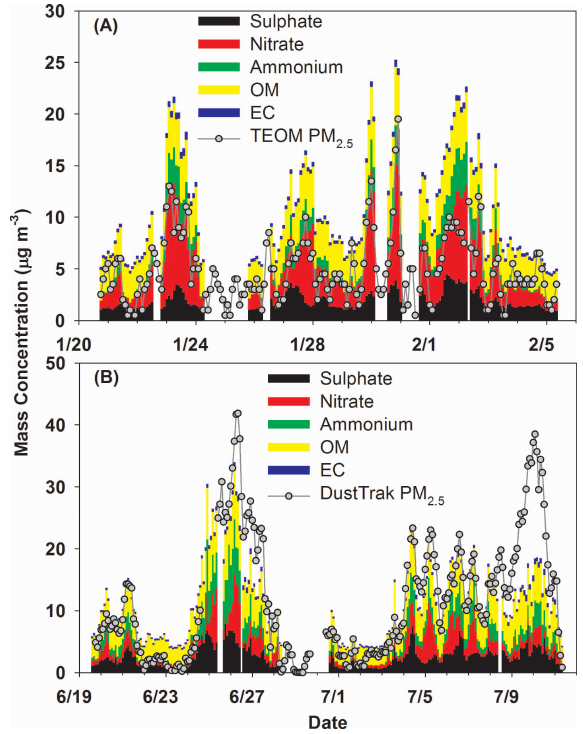
Fig. 6. Stacked two hour resolution chemical species calculated by using scaled ATOFMS RPA and measured PM 2 . 5 mass concentra- tions by the TEOM in Toronto (A) and the DustTrak in Harrow (B) .